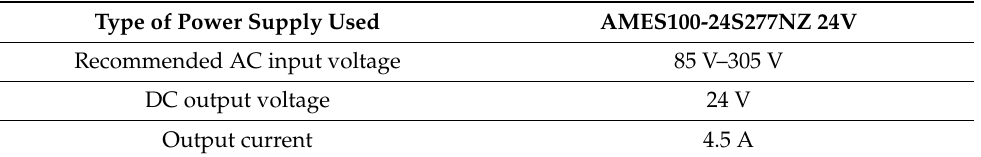
Table 2. Selected technical parameters of the power supply [29].